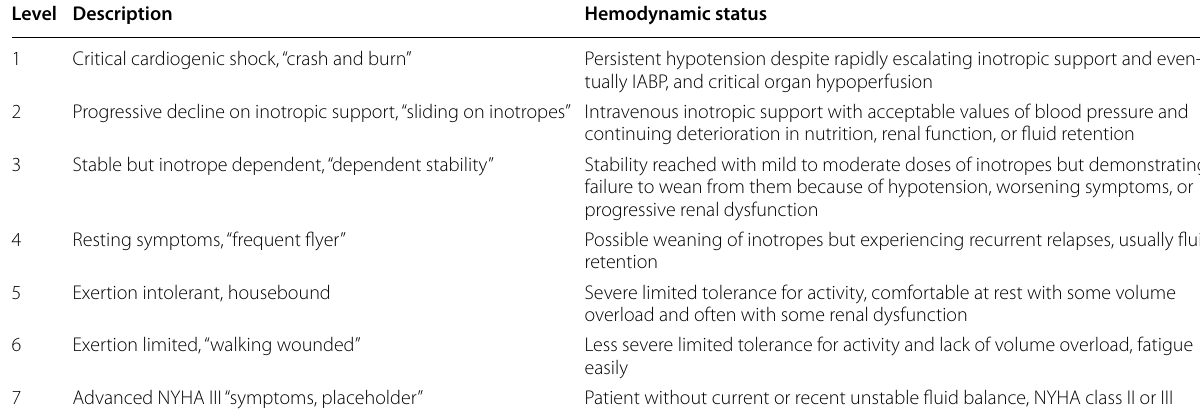
INTERMACS Interagency Registry for Mechanically Assisted Circulatory Support, NYHA New York Heart Association functional